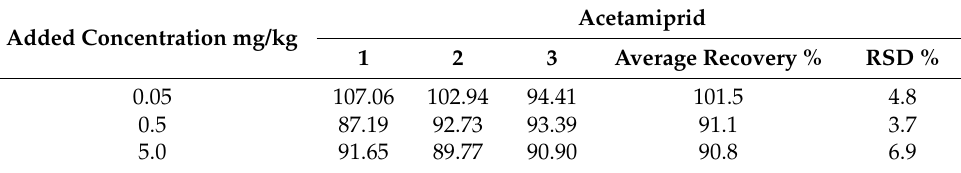
Table 3. Added recovery rate of acetamiprid.